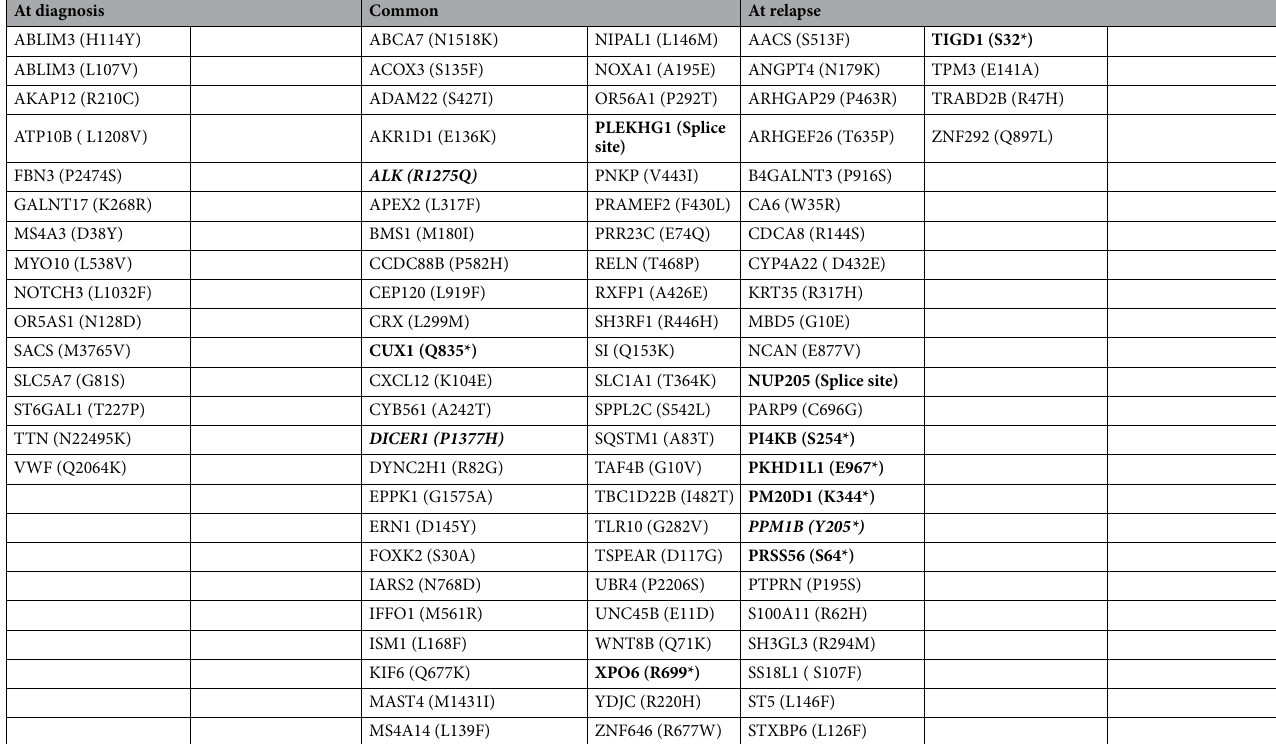
Table 3. Overview of nonsynonymous somatic SNVs, either shared or unique to primary of relapsed tumors, respectively; truncating SNVs indicated in bold and tumorigenic SNVs indicated in